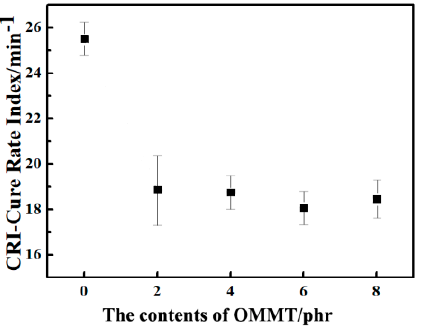
Figure 1. The e ff ects of the contents of OMMT on the cure rate index of carbon black (CB) / natural Figure 1. The effects of the contents of OMMT on the cure rate index of carbon black (CB)/natural rubber (NR) rubber (NR) composites.